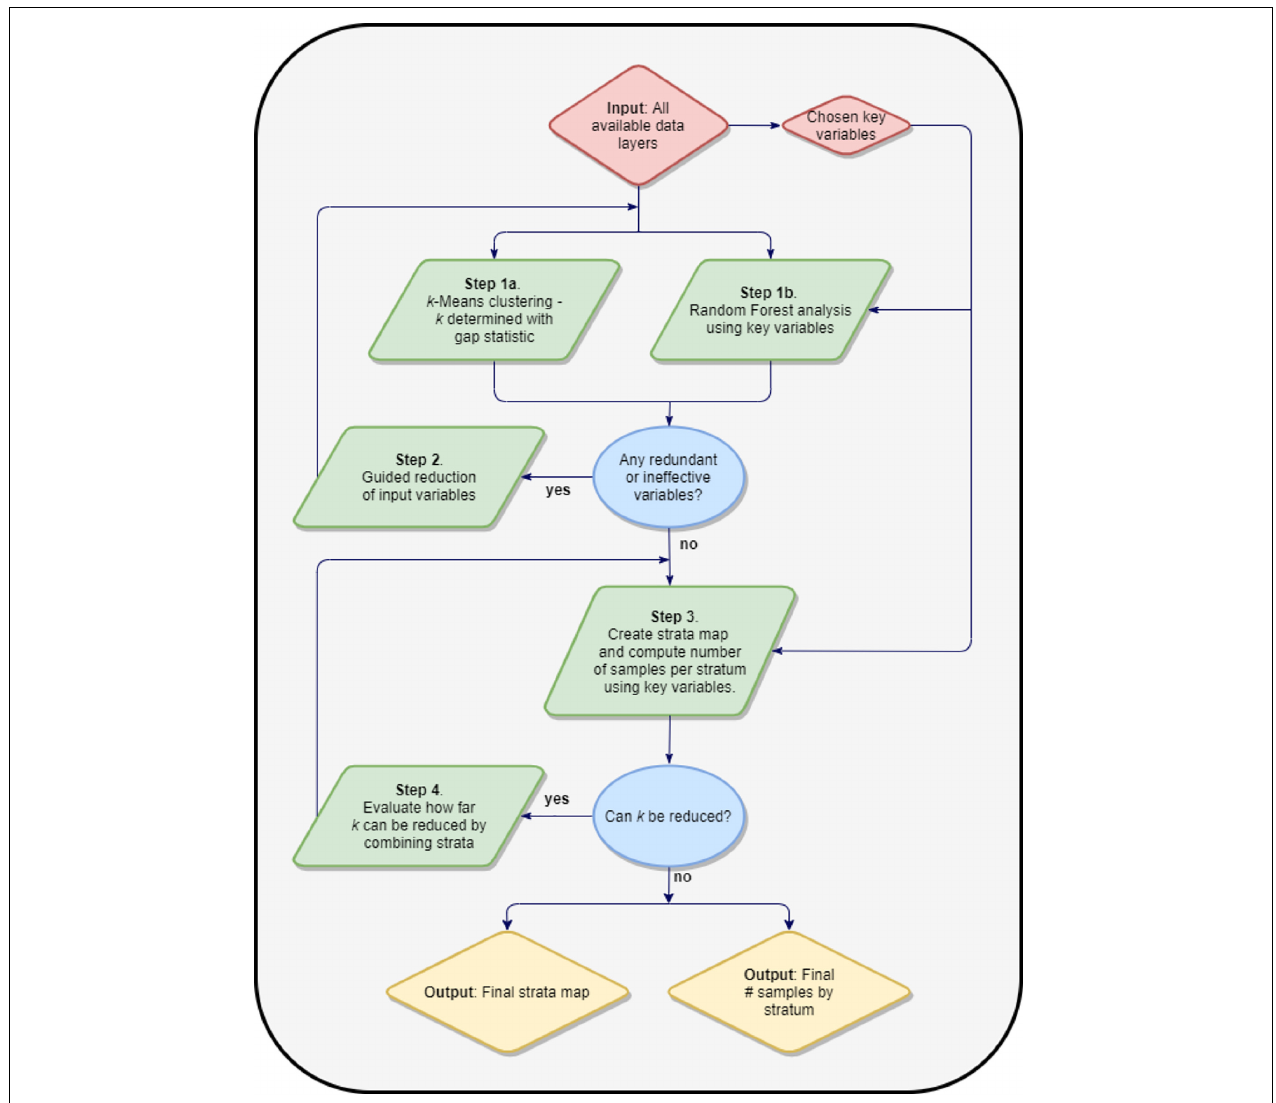
FIGURE 2 | Overview of iterative geospatial clustering and stratification process for coral